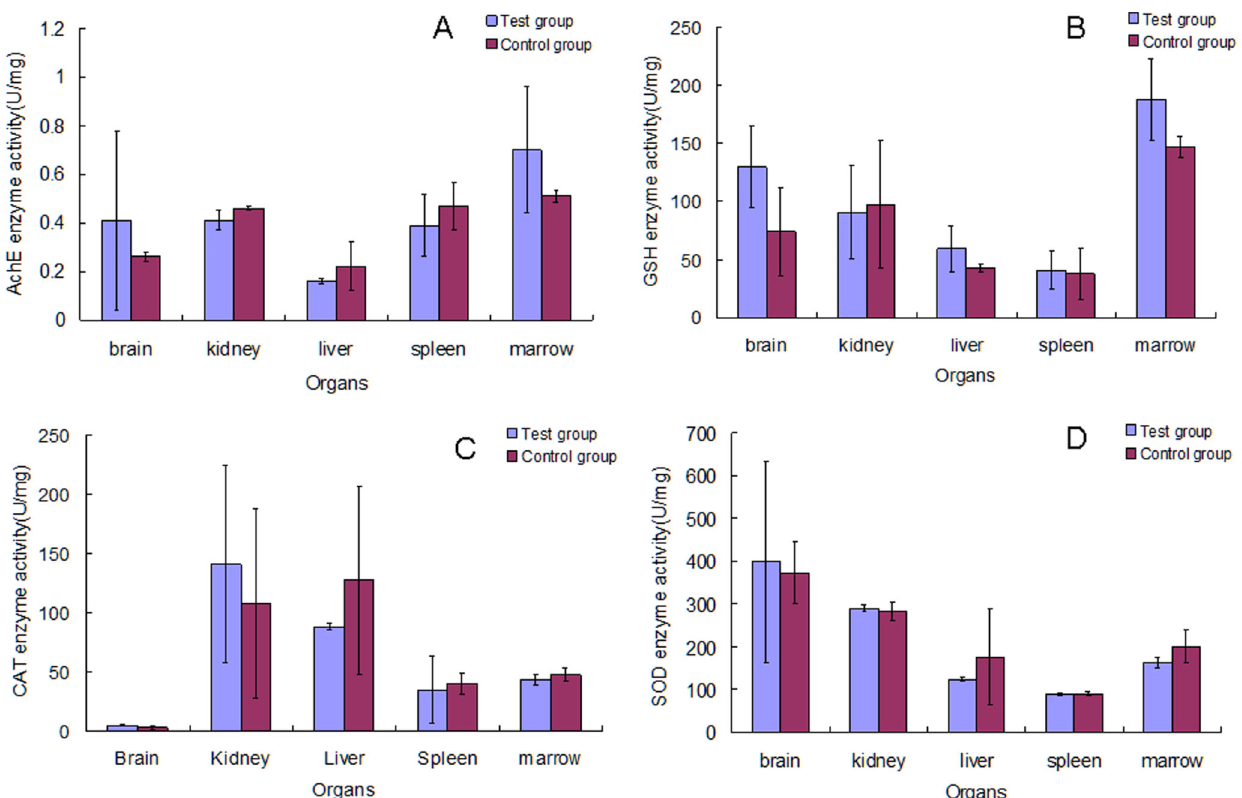
Figure 6. Effect of Cry1Ab protein on the enzyme activity of organs in Swiss rat that feeding for 30 days. The enzyme activities of the organs including brain, kidney, liver, spleen and marrow were assayed. A: the AchE enzyme activity. B: the GSH enzyme activity. C: the CAT enzyme activity. D: the SOD enzyme activity.